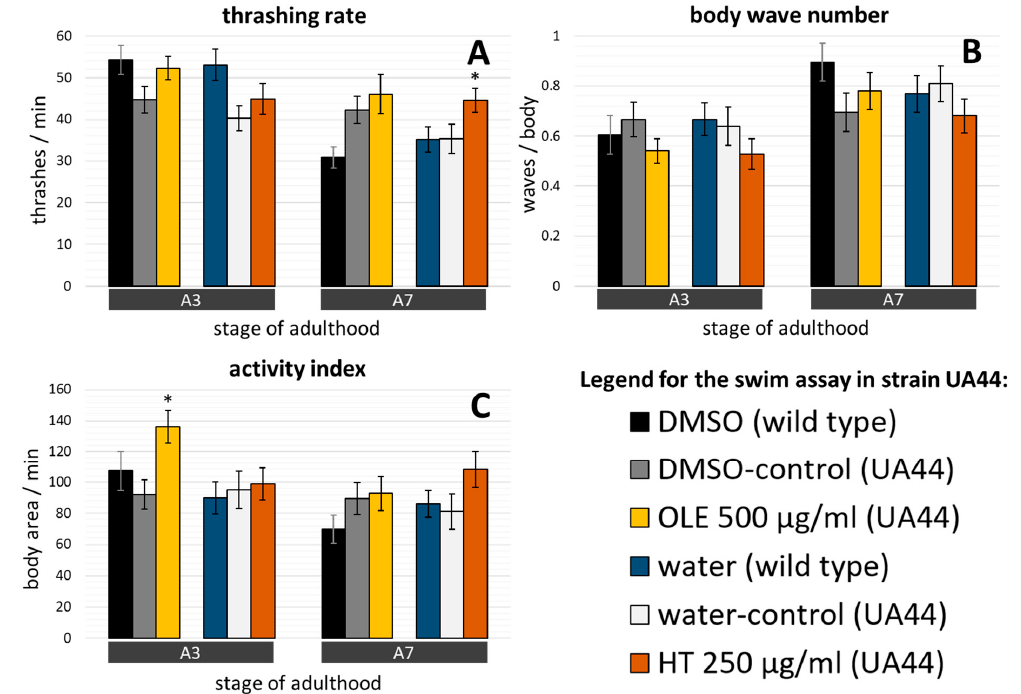
Figure 8. E ff ect of OLE and HT on the swim performance in the C. elegans UA44 strain. ( A ) The number of thrashes per minute, ( B ) the number of waves running through the body, and ( C ) the area covered by the body per minute were observed in presence and absence of OLE and HT at day 3 and 7 of adulthood in two biological repeats. The UA44 strain used in this study is characterized by α - synuclein in dopaminergic neurons. The bar charts represent the following number of individuals: DMSO control ( n A3 = 63, n A7 = 50), OLE ( n A3 = 72; n A7 = 55), water control ( n A3 = 57, n A7 = 55) and HT ( n A3 = 48, n A7 = 65). n : number of tested nematodes. A3, A7: day 3, 7 of adulthood. Data are represented as mean ± SEM and differences compared to control were considered significant at p < 0.05 (*). To enable direct comparisons, data from wild type nematodes without polyphenol exposures (see Figure 5) are shown in addition.